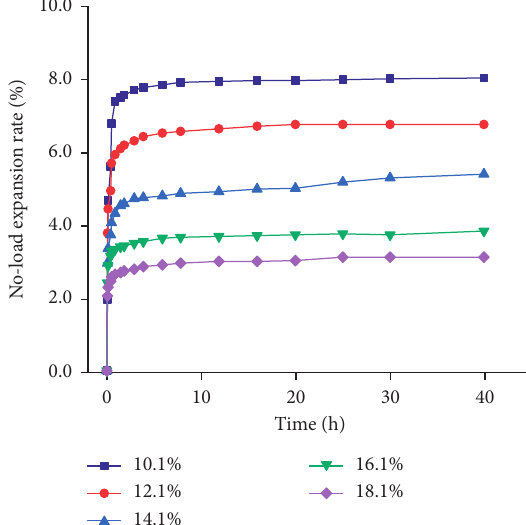
Figure 13: Time variation curve of the unloaded expansion of remolded soil.